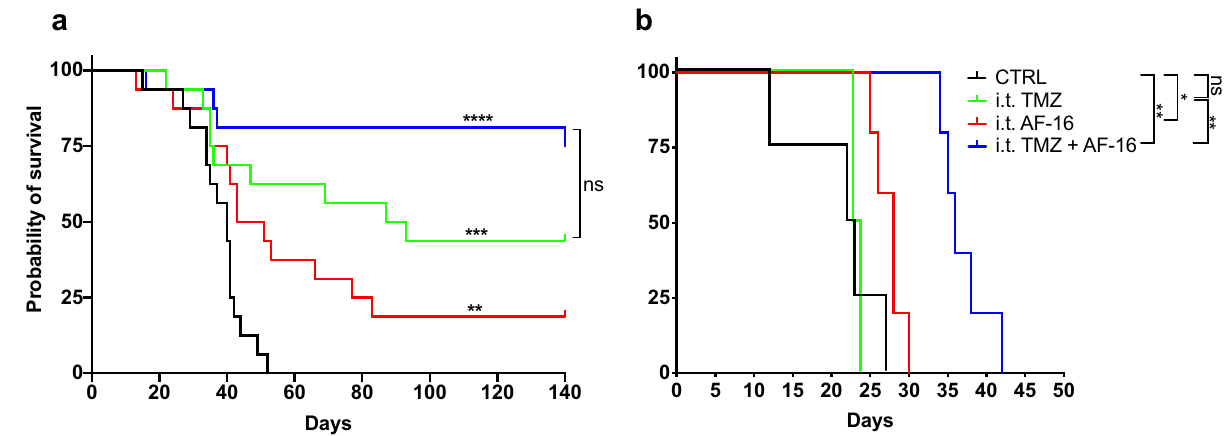
Figure 1. The effect of intratumoral AF16 on survival. Kaplan–Meier survival curves for C57BL/6 ( a ) and NOD- Prkdc scid ( b ) mice orthotopically inoculated with the syngeneic murine glioblastoma cell line GL261 into the right hemisphere and later treated with AF16, TMZ, and AF16 + TMZ solutions in CED pumps. In ( a ), untreated C57BL/6 mice (black curve, n = 14) are compared with TMZ alone (green curve, n = 16, p < 0.001 ***), AF16 alone (red curve, n = 16, p < 0.01 **), and AF16 with TMZ (blue curve, n = 16, p < 0.0001 ****). TMZ alone compared to AF16 with TMZ showed p = 0.085. In ( b ), untreated NOD- Prkdc scid mice (black curve, n = 4) are compared with TMZ alone (green curve, n = 4, p = 0.774), AF16 alone (red curve, n = 5, p = 0.035 *) and AF16 with TMZ (blue curve, n = 5, p < 0.01 **). TMZ alone compared to AF16 with TMZ showed p < 0.01 **. All log rank